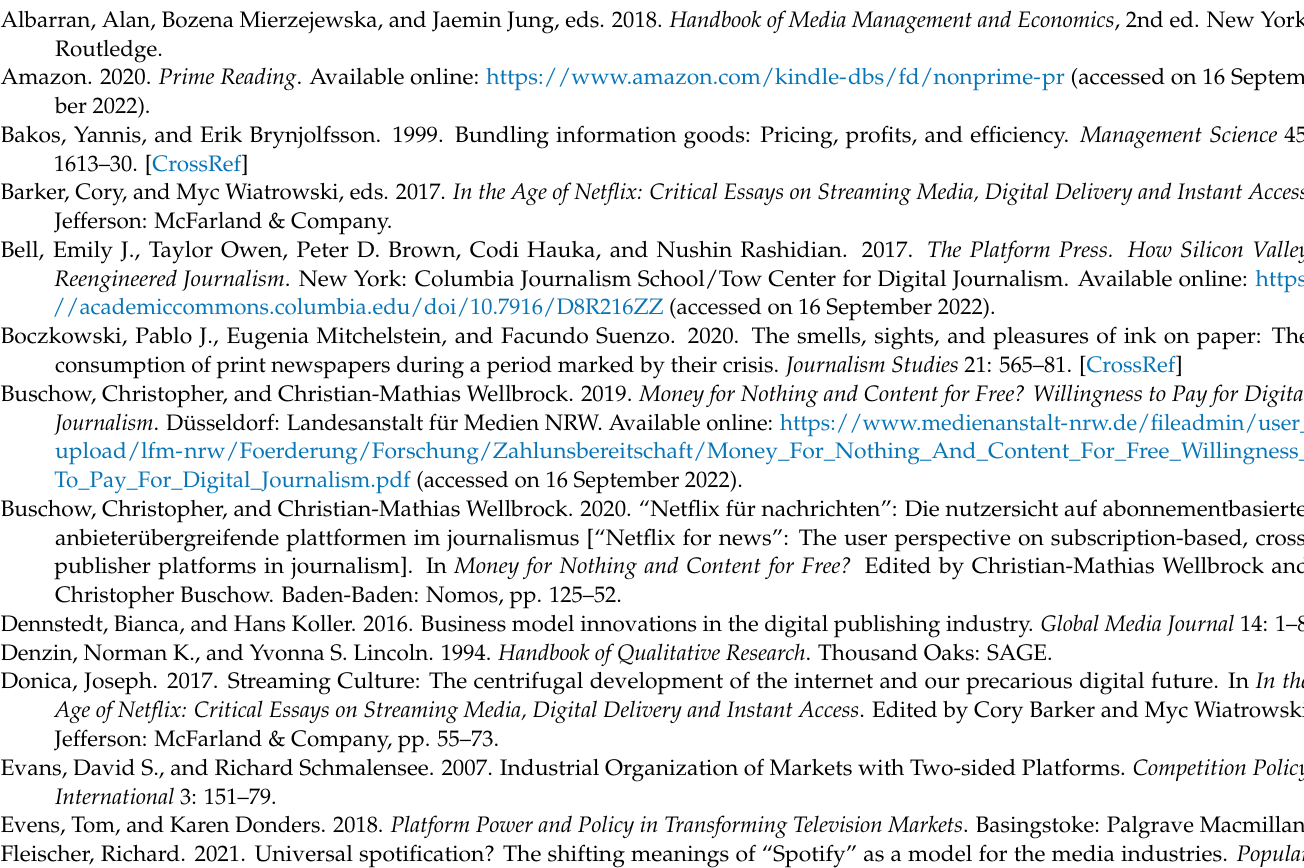
online news. For a fixed monthly fee you can read all the articles from hundreds of newspapers and magazines using an app newspapers. Apple has just introduced such a service in the USA, while “Readly” has been available in Germany for several not further confronted with the example platform products (e.g., by means of screenshots, showing the websites/apps, etc.) to avoid participants from being overly guided by the current market situation, i.e., to reduce priming effects. German weekly quality newspaper. “TÜV” (German: Technischer Überwachungsverein, English: Technical Inspection Agency), as independent companies, test, inspect and certify technical systems, equipment and objects of all kinds in order to minimize hazards and prevent damage. German yellow press